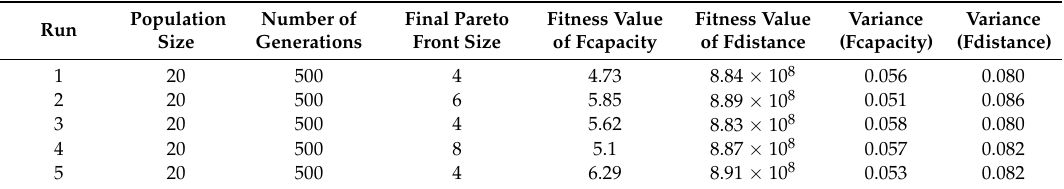
Table 4. Results of repeatability test of the proposed MOABC algorithm.